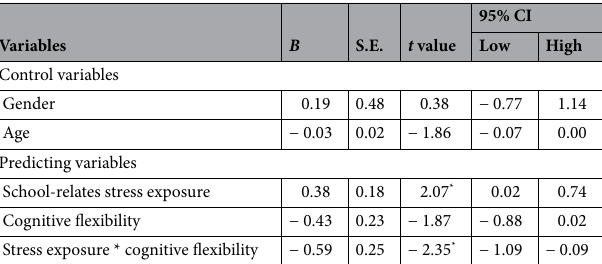
Figure 1. The interactive effect of school-related stress exposure and cognitive flexibility on PTSD symptoms in educators.